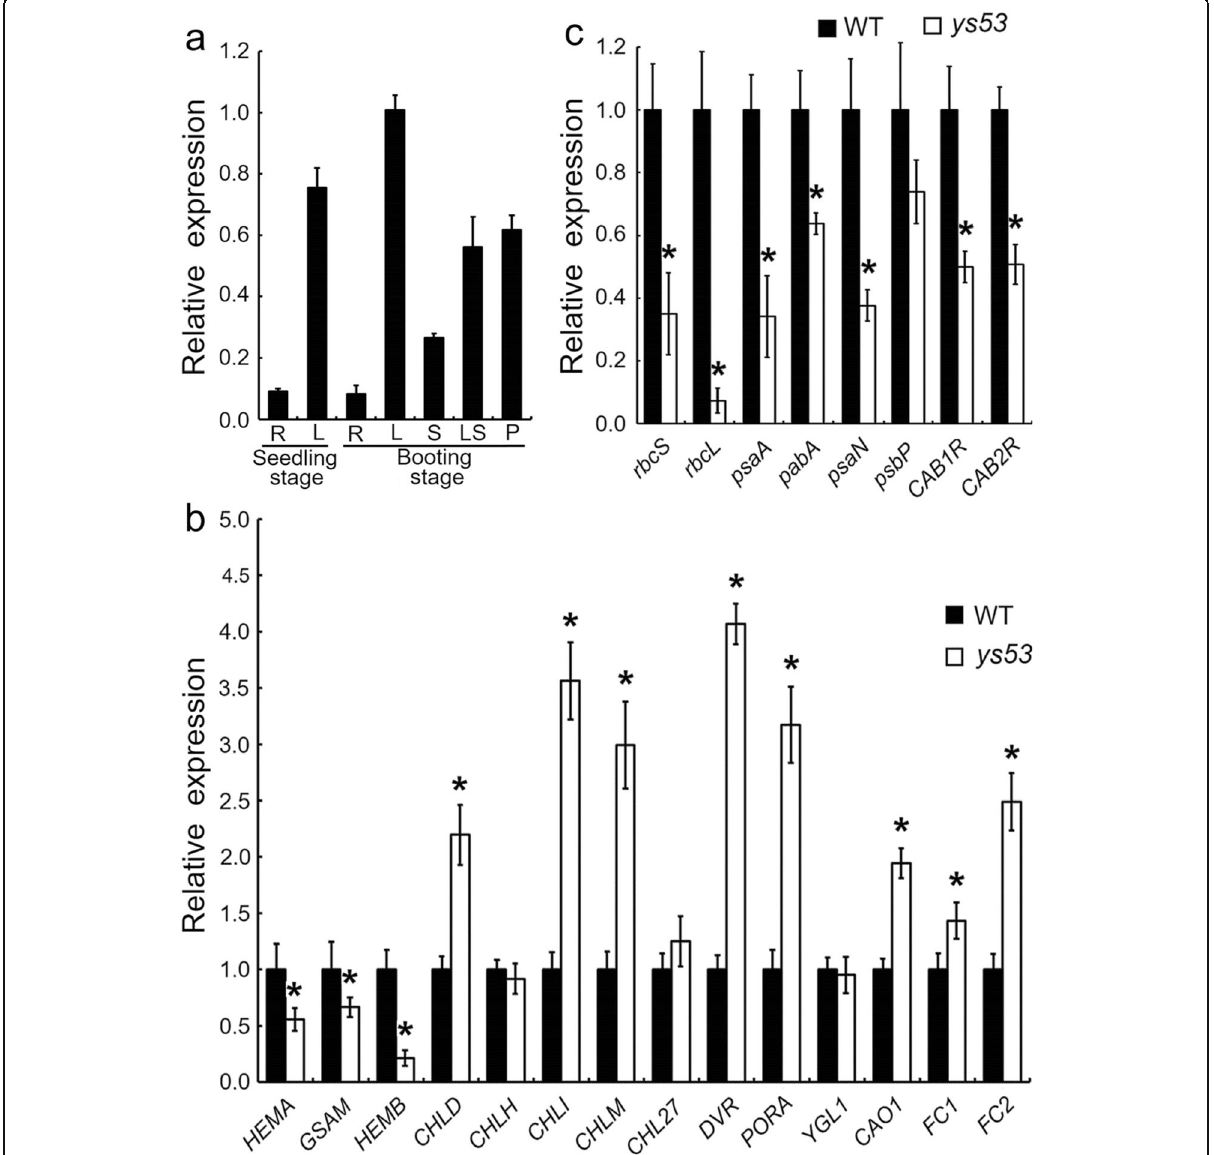
Fig. 7 Expression analyses of related genes by qRT-PCR. a Expression pattern of OsGSAM gene. The total RNA was extracted from different tissues, including root (R), leaf blade (L), stem (S), leaf sheath (LS) and young panicle (P), of the wild type at seedling stage and booting stage, respectively. Rice actin 1 gene was used as an internal control. Error bars represent the SDs of three independent experiments. b and c Comparison of expression levels of the genes associated with tetrapyrrole biosynthesis and photosynthesis, respectively, between ys53 and its wild at seedling stage. The total RNA was extracted from 4-week-old seedlings. The relative mRNA amount of each gene was normalized to Actin 1 . The expression level of each gene in the wild type was set to 1.0, and those in ys53 mutant were calculated accordingly. Error bars represent the SDs of three independent experiments. Asterisks indicate statistically significant differences compared with the wild type at P <